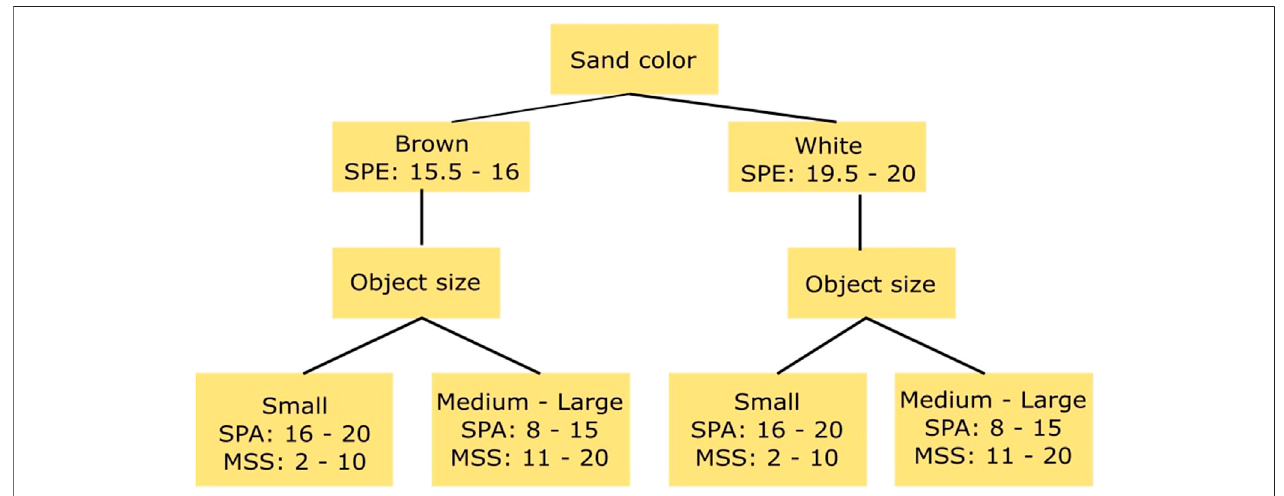
FIGURE3| Decisiontreeforsegmentationparametersbasedonbeachcharacteristicsofthefourstudysites.SPE:SpectralValue,SPA:SpatialValue,MSS:Mean Segment Shift Value.